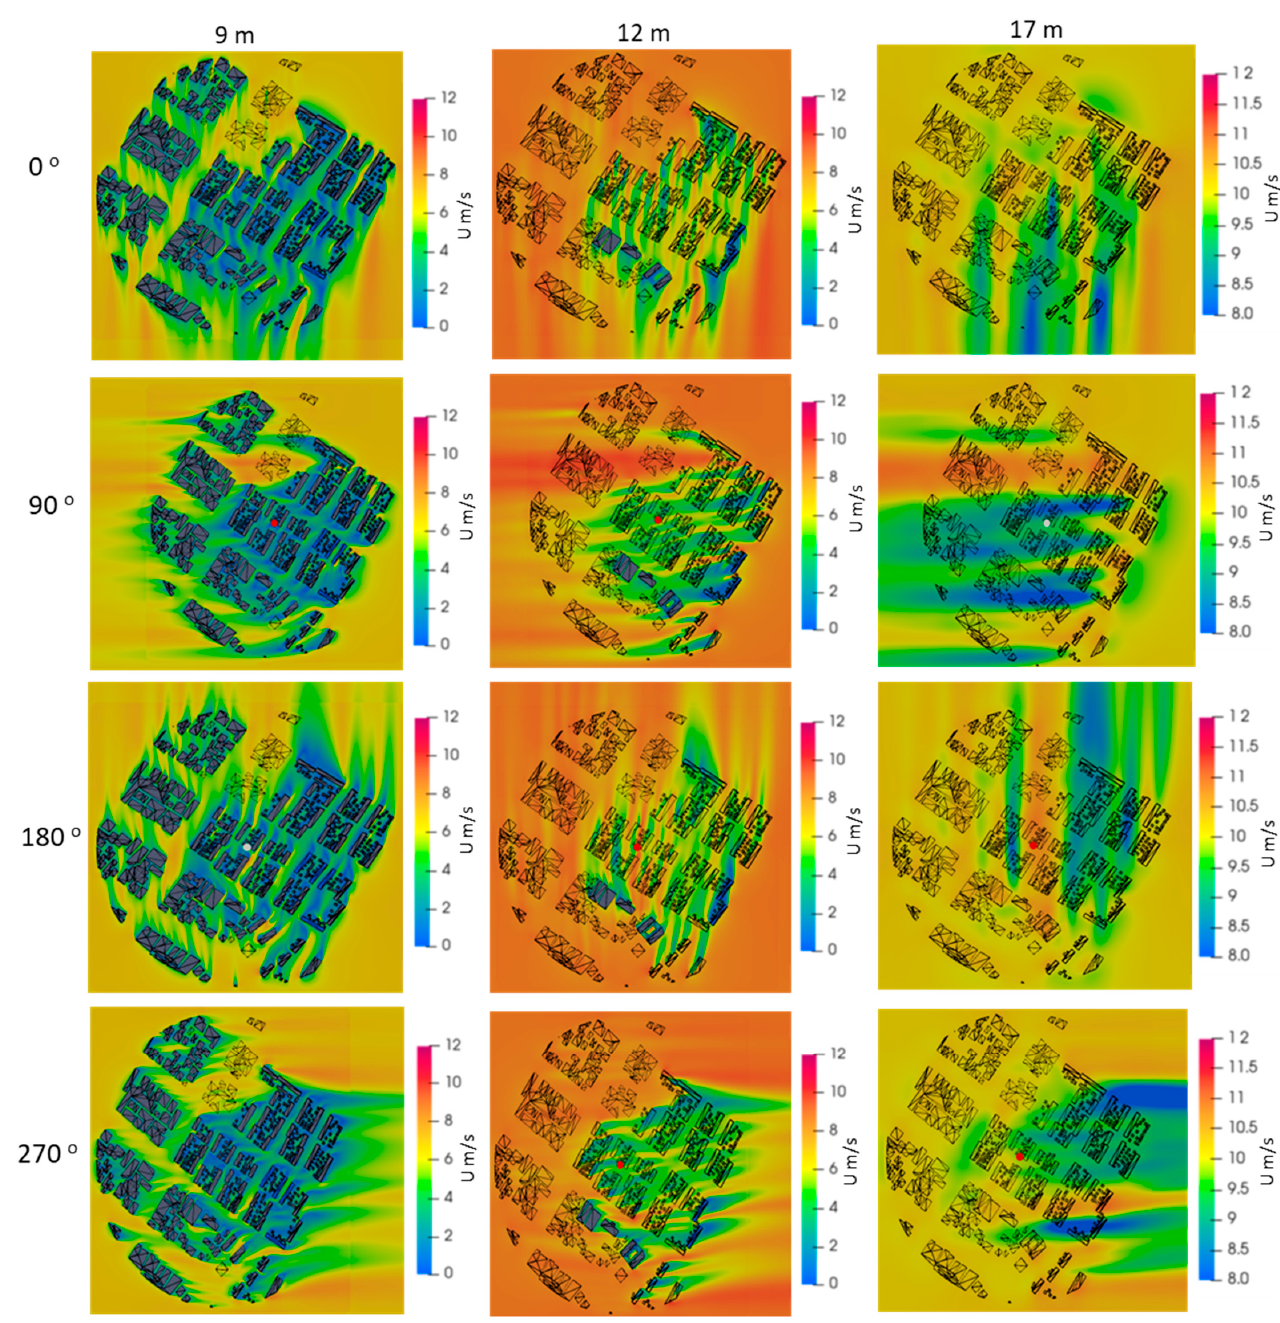
Figure 28. Mean wind speed estimates obtained by the OpenFOAM CFD model for three heights (9 m, 12 m, and 17 m) and four wind sectors rose (0°, 90°, 180°, and 270°).